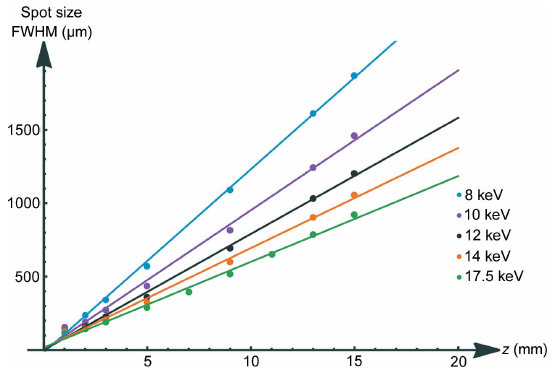
Figure 11 Divergence far from the focal distance of PC-246 for different energies.